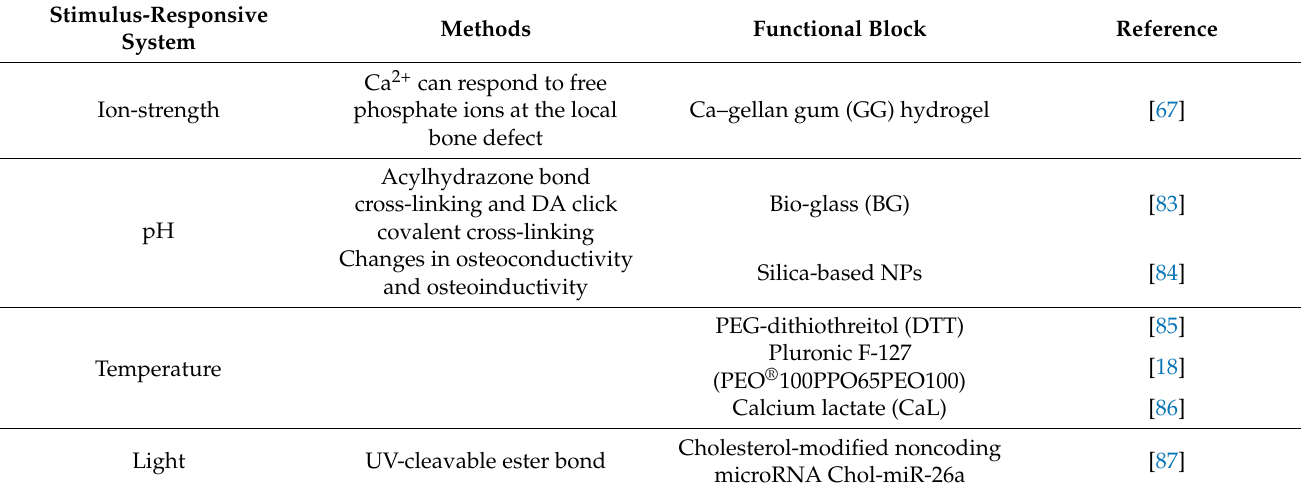
Table 2. Summary of stimulus-responsive systems and methods to be able to respond to different